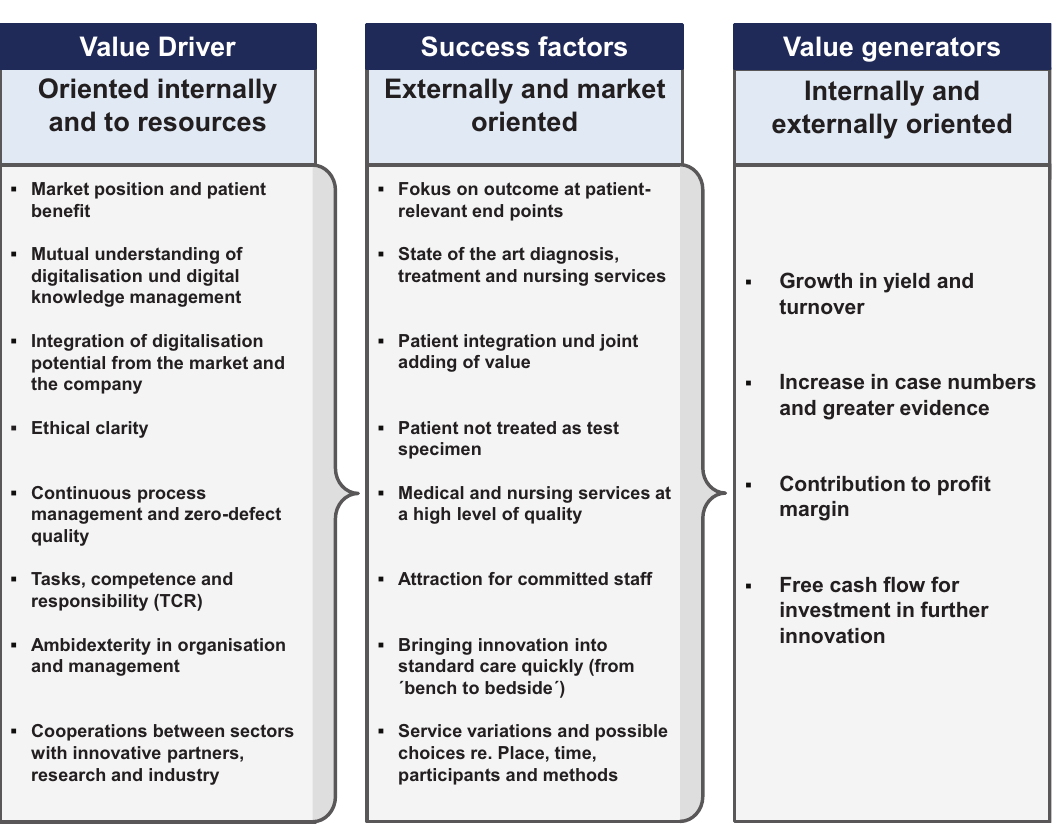
Figure 2. Key value drivers, success factors and value generators of a personalisation of treatment pathways 51